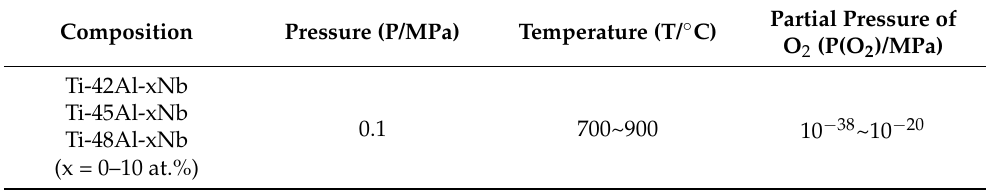
Table 1. Composition, Pressure, temperature, and partial pressure of O ₂ in the present calculation.